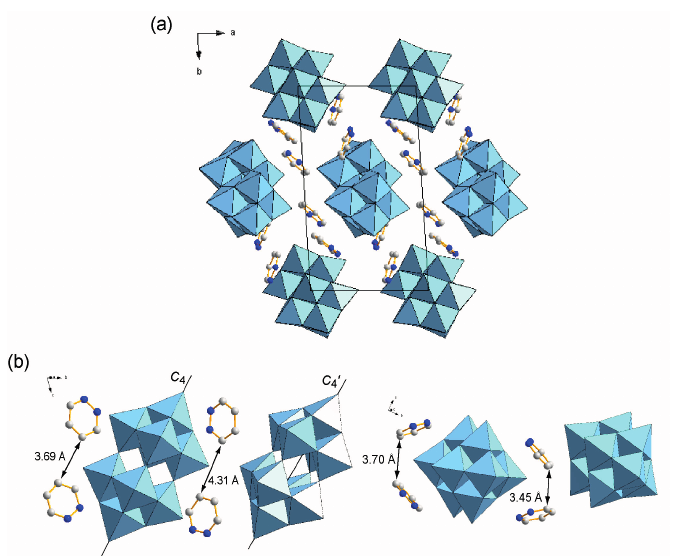
Figure 3. Molecular arrangements in the inorganic layers of 1 (C: gray, N: blue; W 10 anions in polyhedral representations. H atoms and the dodecyl groups are omitted for clarity).